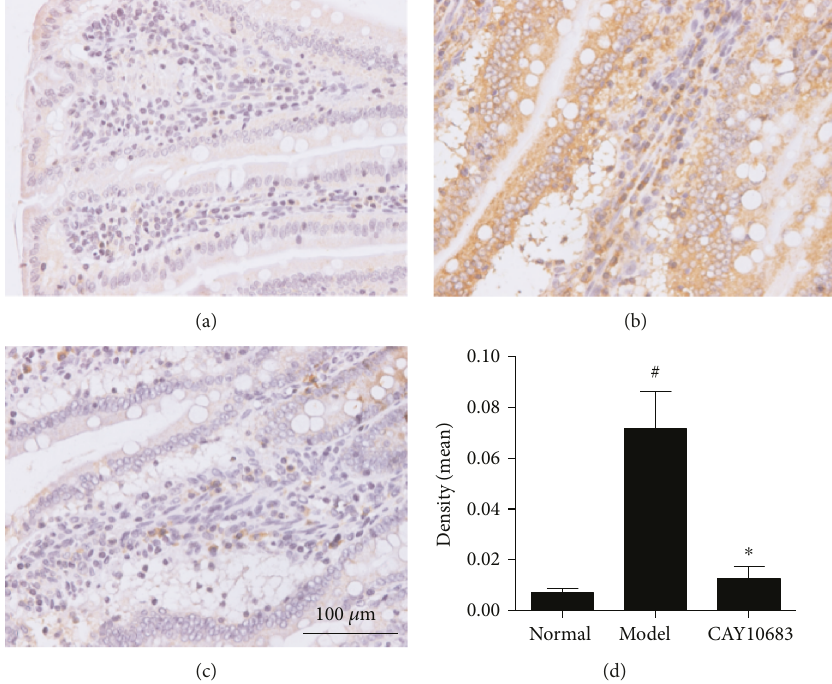
Figure 6: (a – d) Detection of TLR4 protein level in liver tissues with IHC method: (a) normal group, (b) model group, and (c) CAY10683 group. Values are expressed as mean ± SD. # P < 0 05 , compared with normal group; ∗ P < 0 05 , compared with model